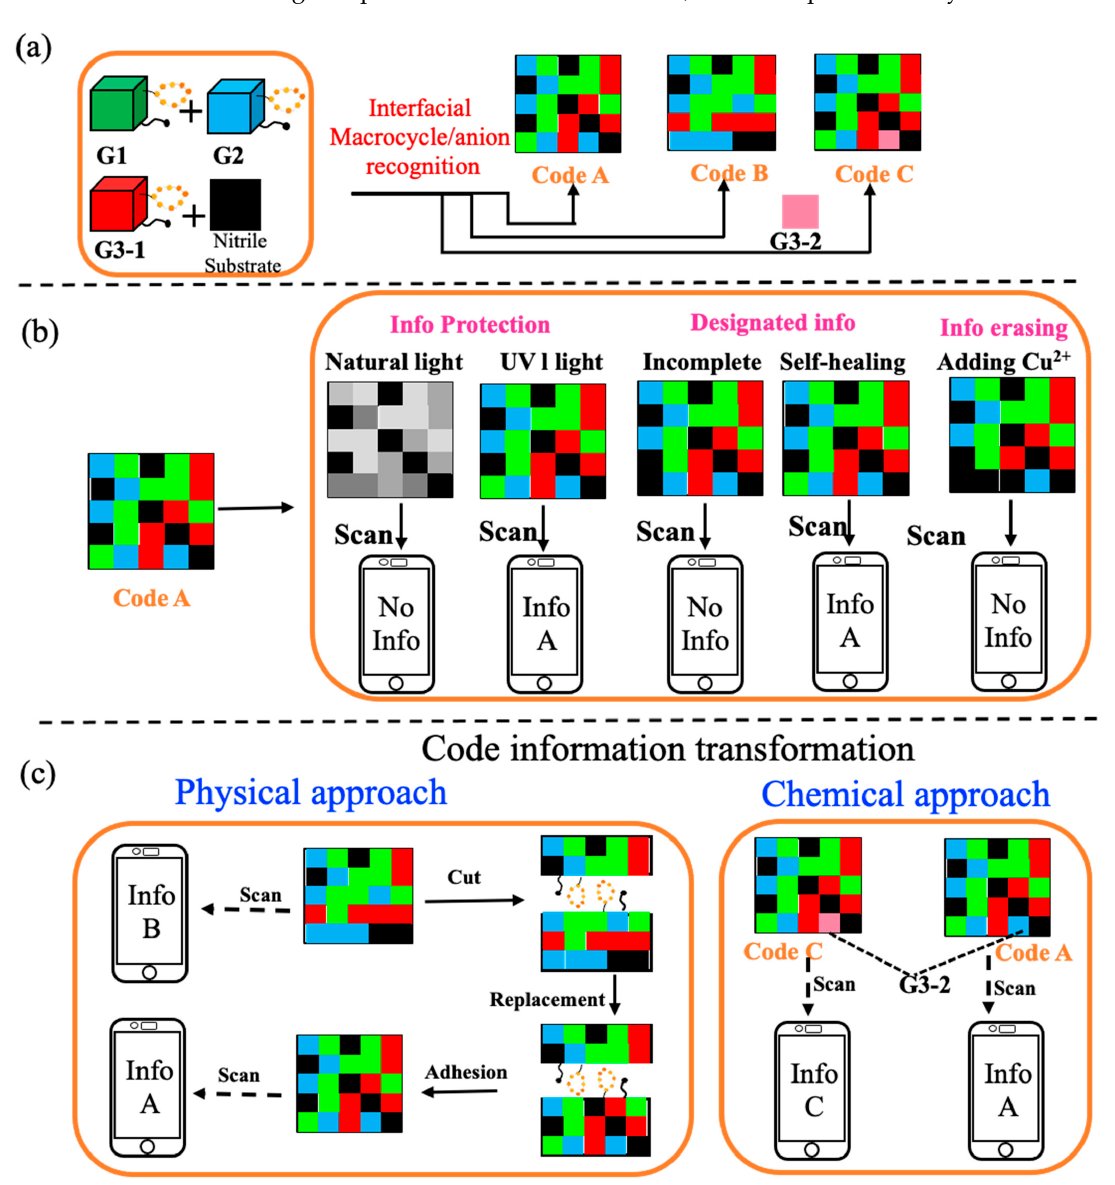
Figure 10. ( a ) Cartoon representation of construction of 3D color codes through the interfacial adhesion of various colored hydrogels. ( b ) Code used for information protection, designated information, and information erasing. ( c ) Schematic view showing how initially encrypted information could be transformed by physical and chemical means. Reproduced with permission from ref [56]. Copyright 2018 Wiley-VCH.